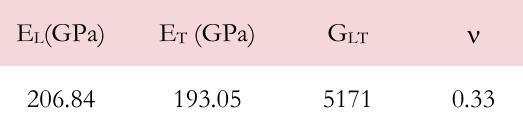
Table 2: Mechanical properties of